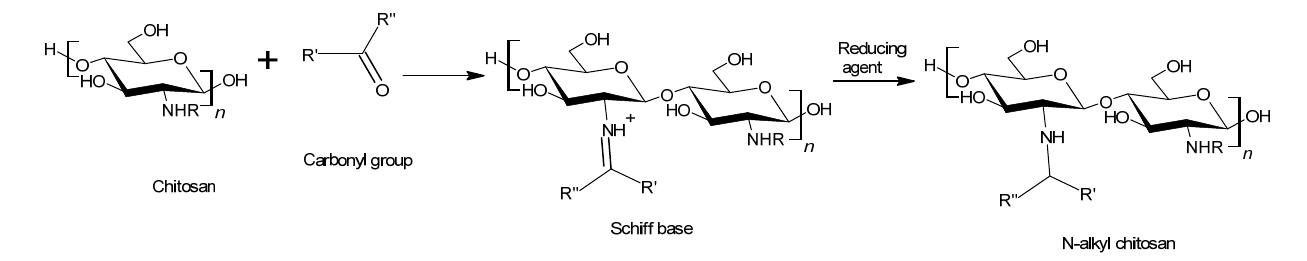
Figure 7. Alkylation reaction process of chitosan.